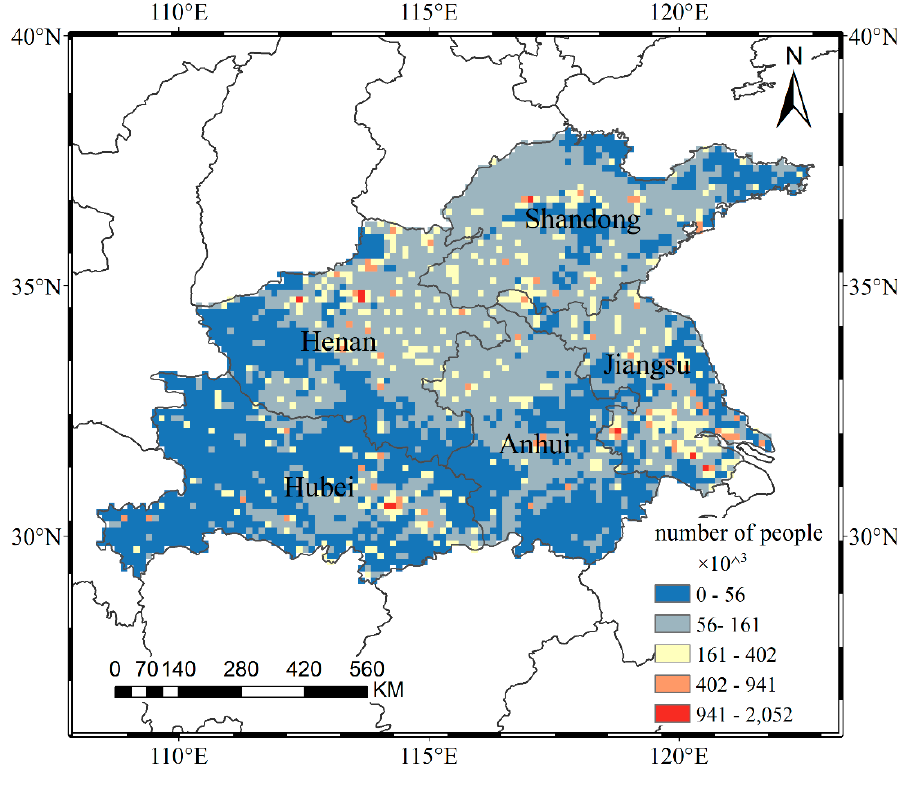
Figure 2. Spatial distribution of the population in 2016.